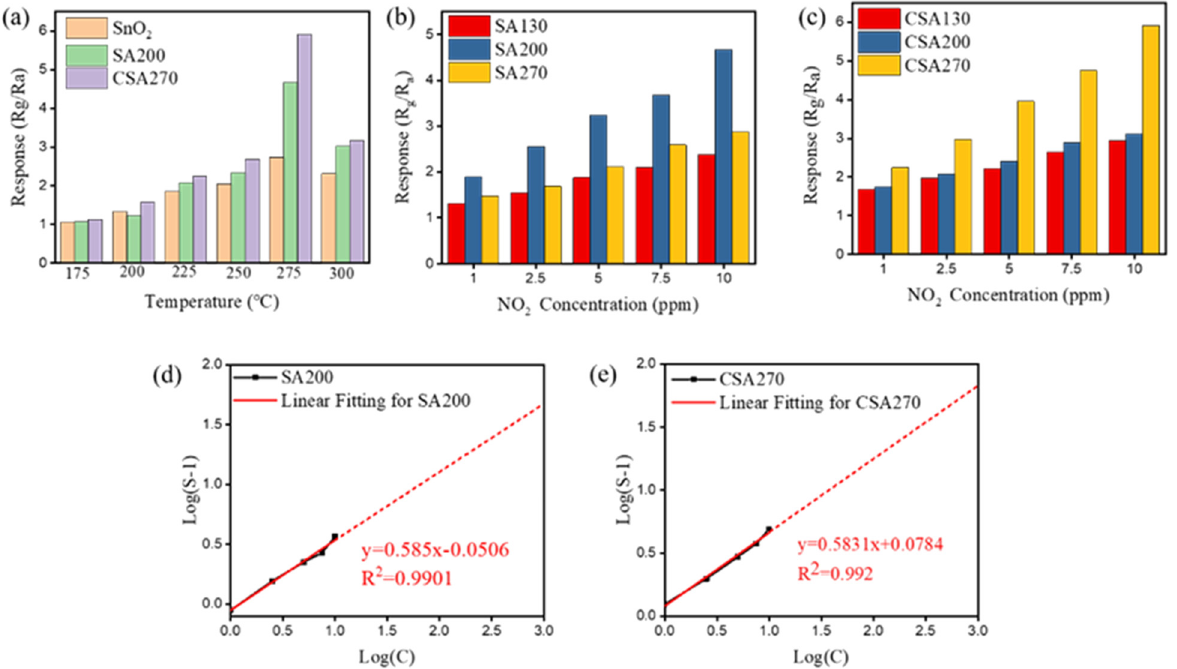
Figure 9: ( a ) Operating temperature - dependent 10 ppm NO 2 gas - sensing response for SnO 2 , SA200, and CSA270 sensors. Gas - sensing response versus NO 2 gas concentration for ( b ) SA series and ( c ) CSA series sensors at 275°C. The NO 2 gas sensing prediction and linear fi tting by log ( S − 1 ) versus log ( c ) plot for ( d ) SA200 and ( e ) CSA270